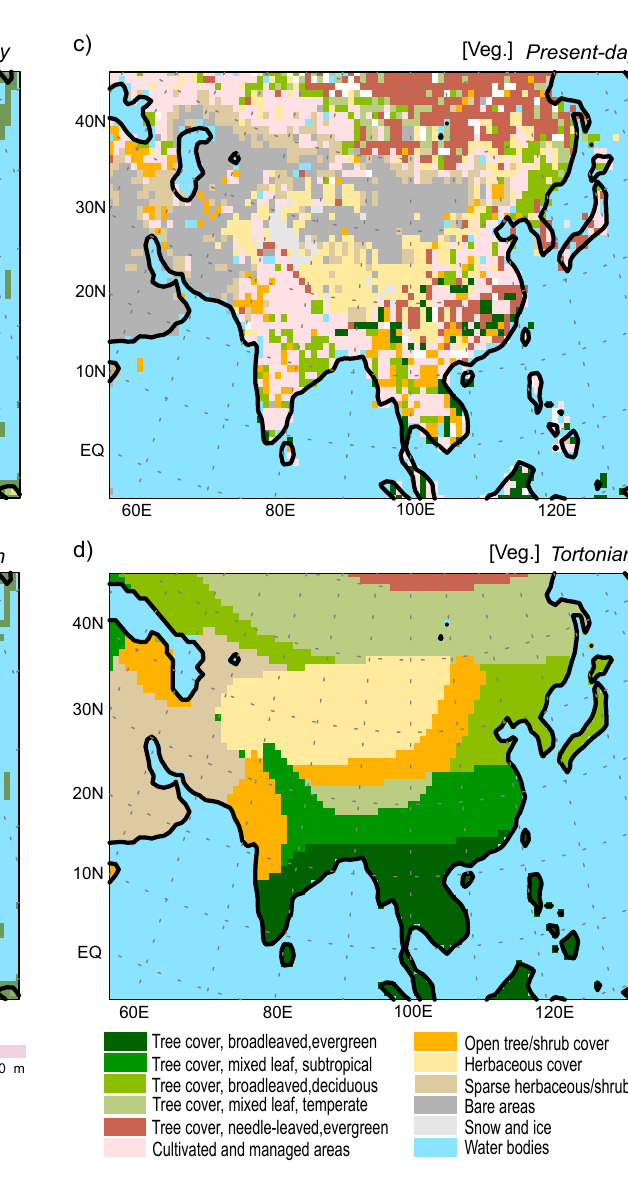
Fig. 3. The orography and vegetation for the present-day control run (CTRL) (a, c) and the Tortonian run (TORT) (b, d) of the regional model. The maps are displayed in the original rotated model grid. The present-day vegetation is based on the GLC2000 data set (http: //bioval.jrc.ec.europa.eu/) which is used in the regional model by